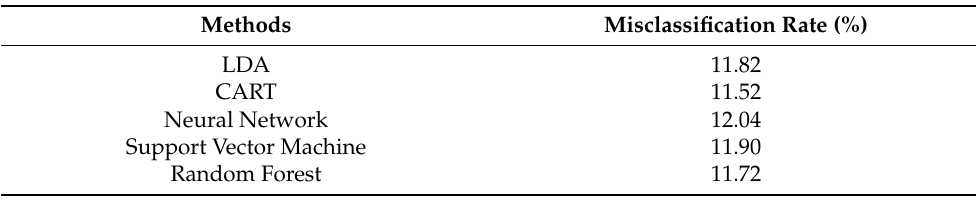
Table 4. Misclassification Rates in 100 Simulations.